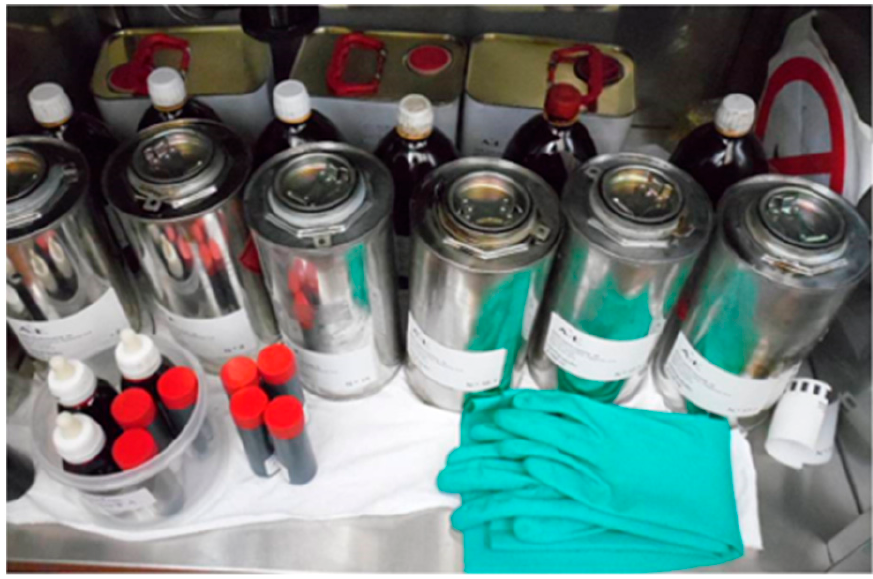
Figure 12. Emulsion samples